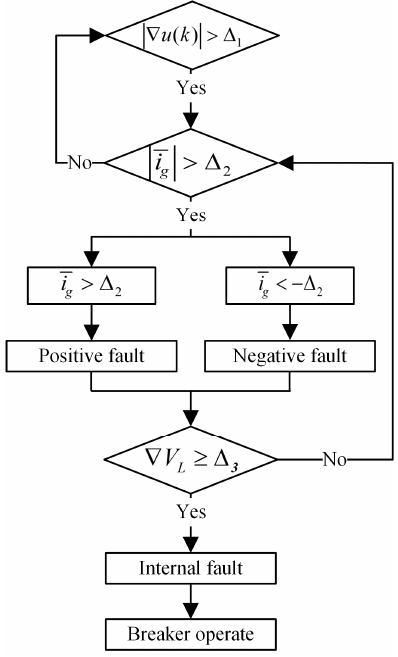
Figure 15. Proposed protection scheme.